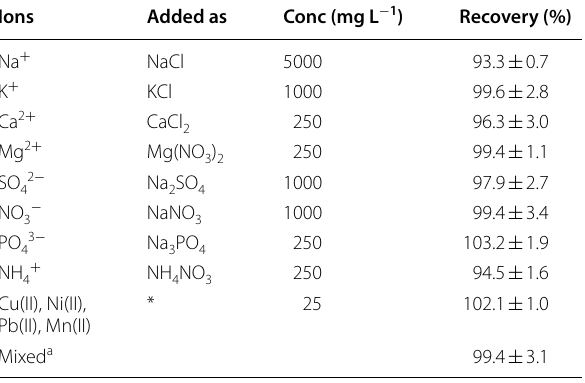
Table 6 Different common ions effect on the Cd(II) extraction efficiency